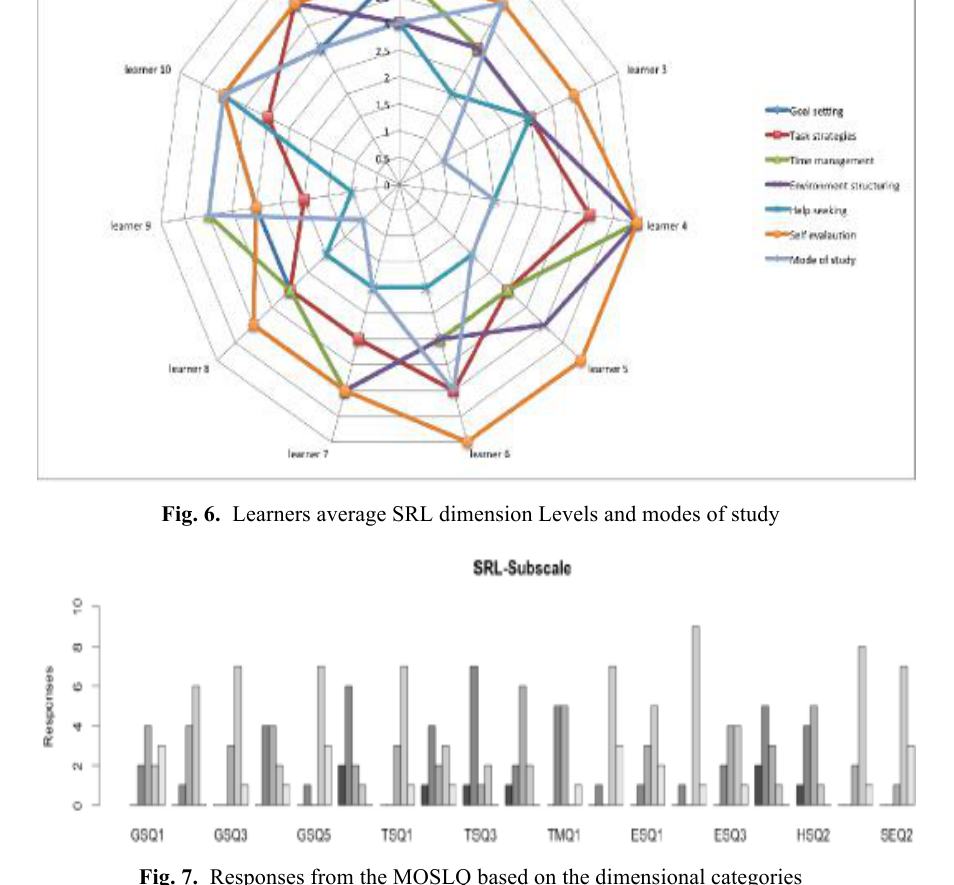
Fig. 7. Responses from the MOSLQ based on the dimensional